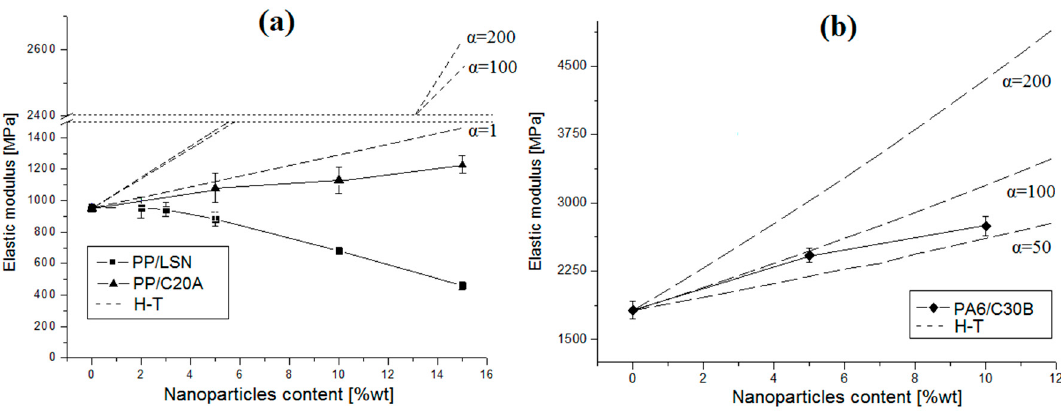
Figure 7. Elastic modulus of nanocomposites: ( a ) PP/LSN and PP/C20A; and ( b ) PA6/C30B.